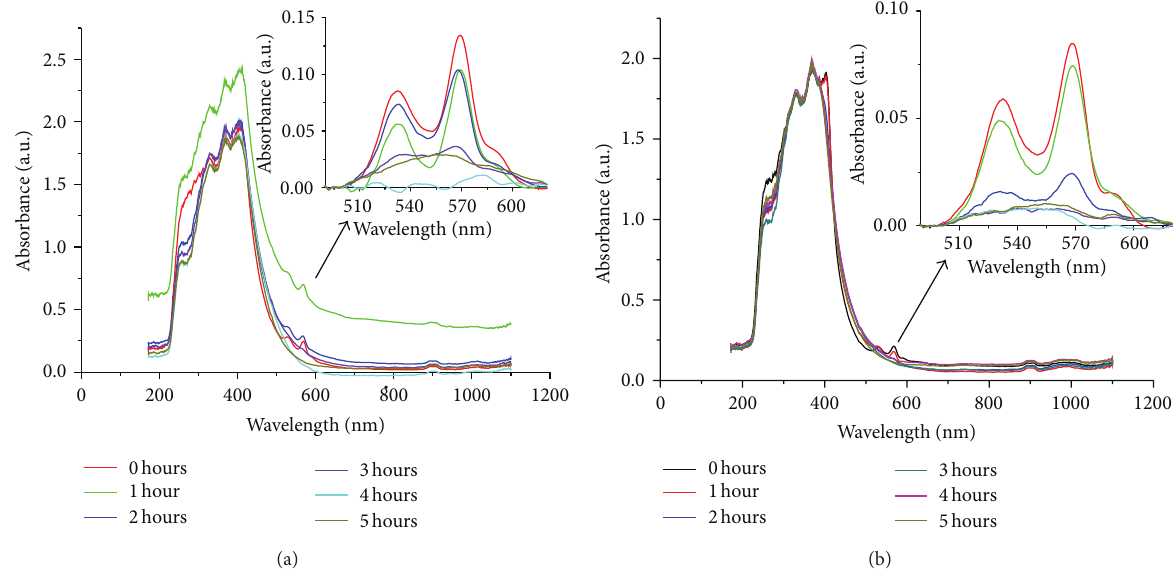
Figure 4: UV-Vis absorbance spectra as a function of illumination time in the presence of the TiO 2 nanomaterial with the crude oil extracts: (a) COE-TiO 2 and (b) COEW-TiO 2 . The insets show the bands observed at 530 nm and 569 nm.